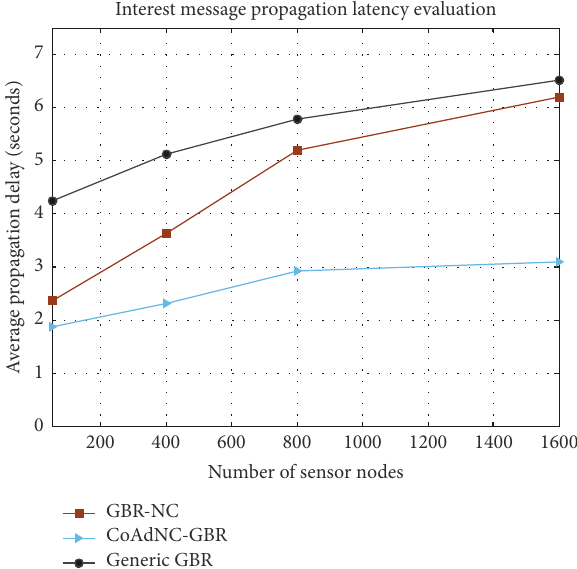
Figure 6: The CoAdNC-GBR Interest message propagation